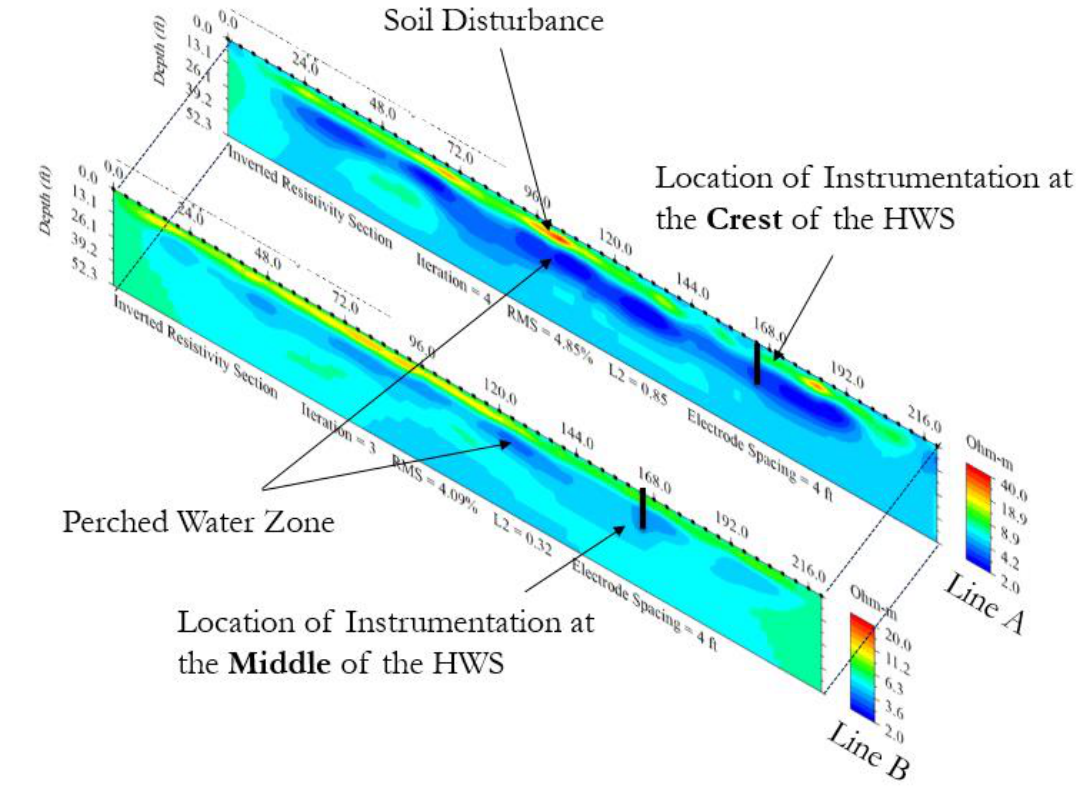
Figure 30. HWS 6, 2D ERI test profile at line A and at line B tested on 15 January 2021 (1 ft = 0.3 m).